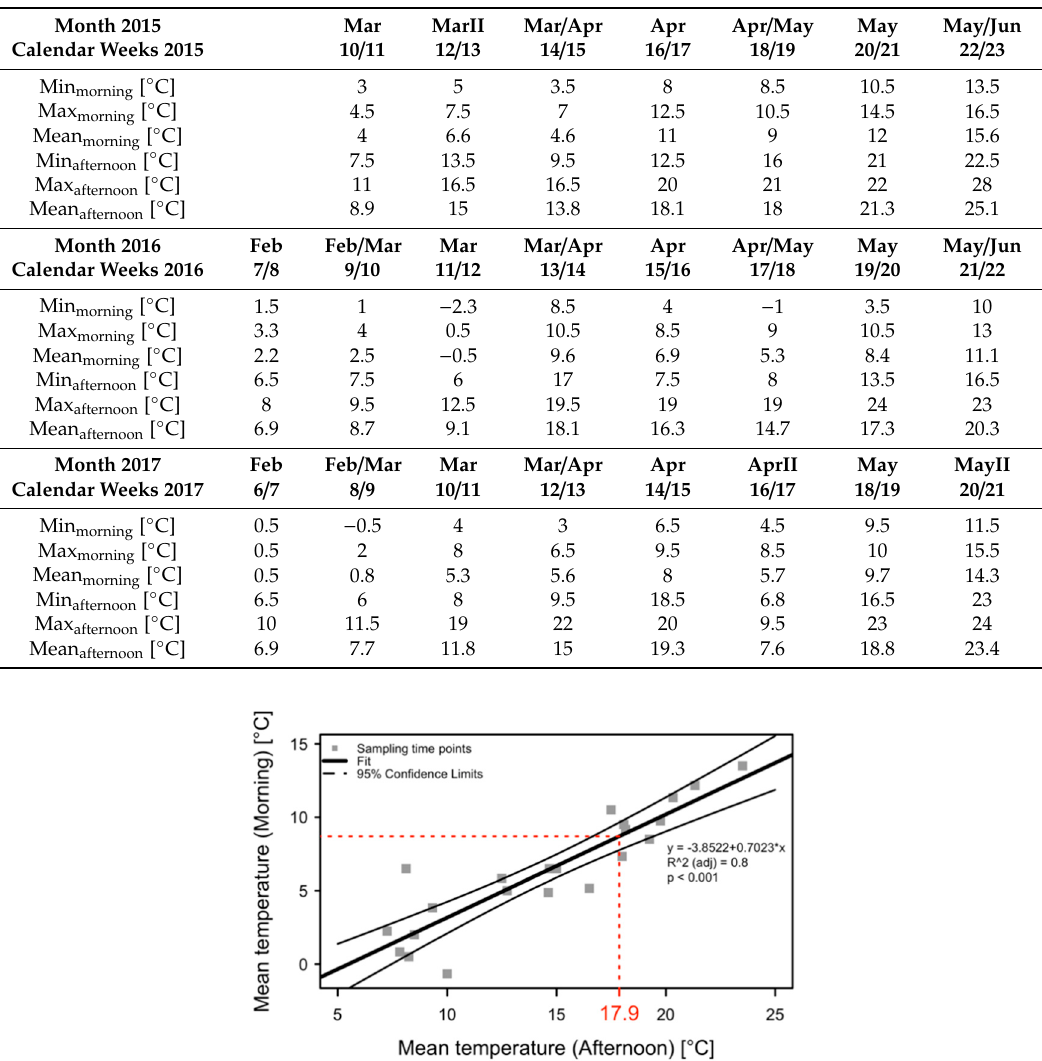
Table A1. Minimum, maximum and mean temperatures at two daytimes of sampling (morning: 7–9 a.m.; afternoon: 2–4 p.m.), in the studied apple orchard per each two calendar weeks from 2015 until 2017.